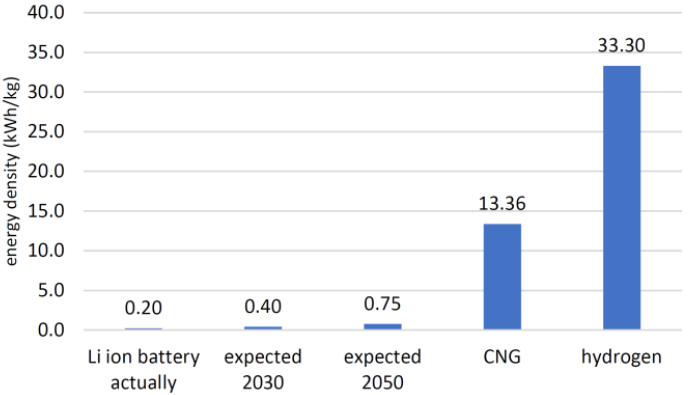
Figure 1. The energy density of Li-ion batteries in comparison to CNG and hydrogen (for the predictions, cf. Section 3.4) .